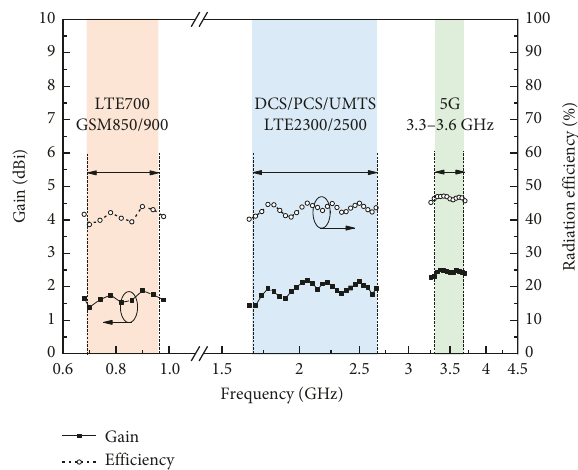
Figure 9: Measurement results for the gain and efficiency of the proposed